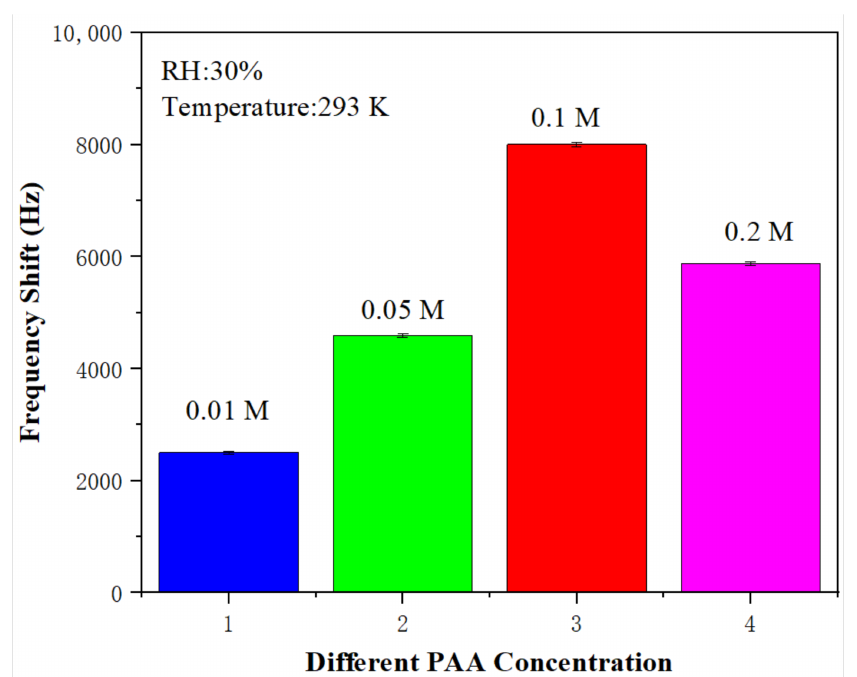
Figure 4. FTIR spectra of PAA film.